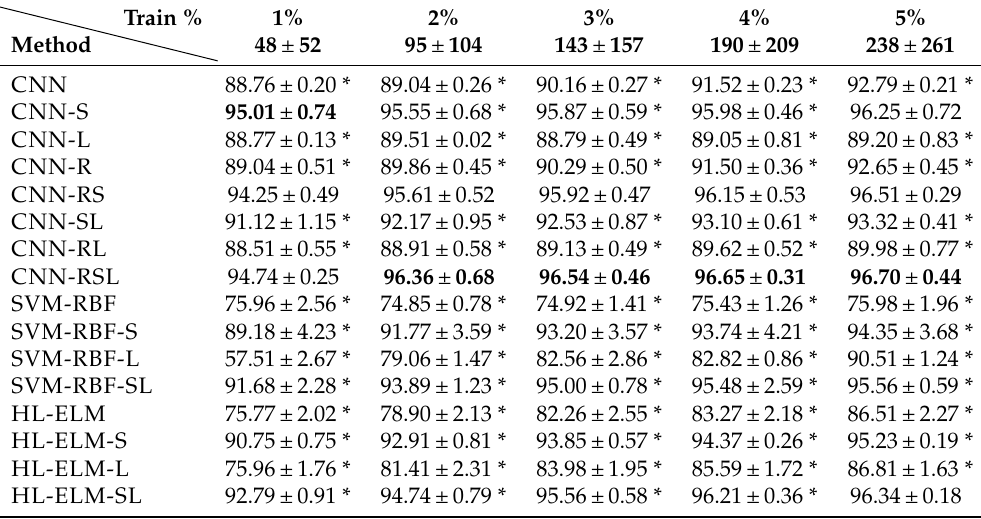
Table 4. Test set classification accuracy on the Pavia University dataset, when using 1–5% randomly sampled labeled pixels per class for training. We report the mean and standard deviation over 10 runs. We also list the mean and standard deviation of the number of training pixels per class for each training %. The best accuracy for each training set is indicated in bold. An ‘*’ means that the best accuracy is significantly better than the accuracy achieved by the corresponding method according to a binomial test for comparing classifiers [45] ( p -value <